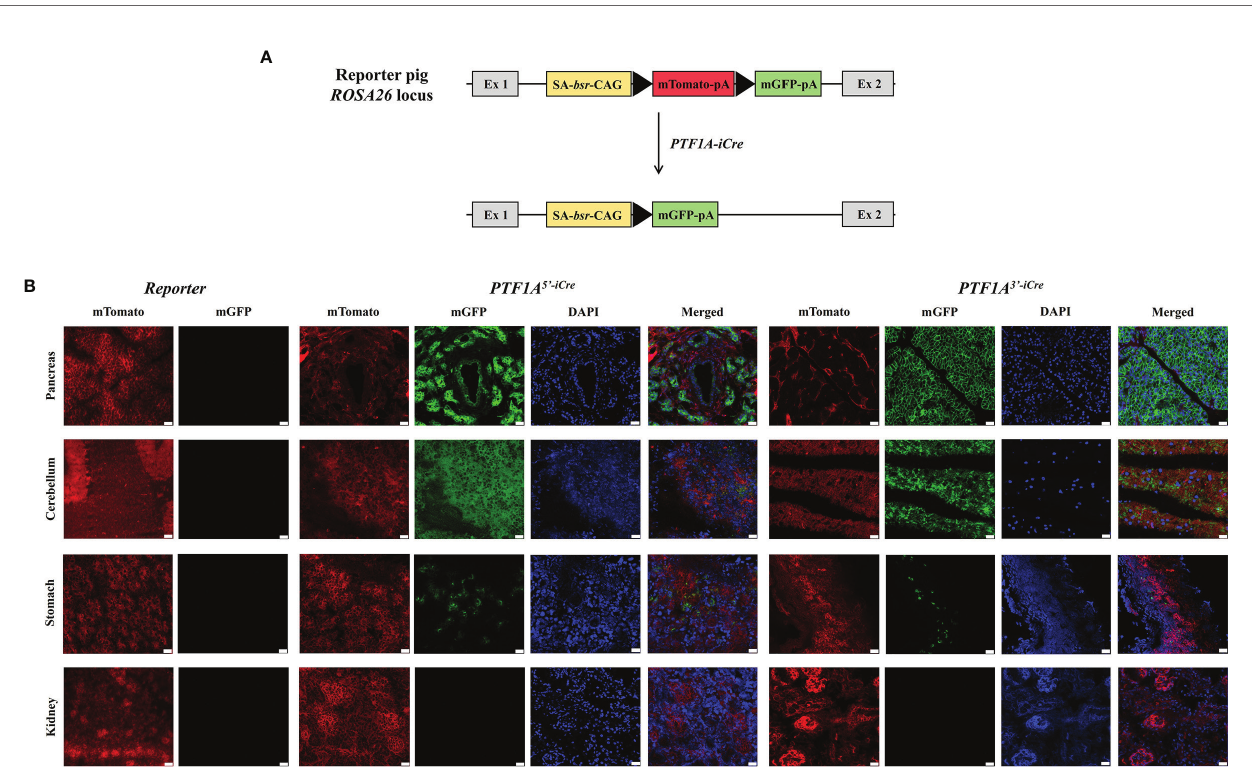
FIGURE 3 | Functional analysis of PTF1A-iCre using dual fl uorescent reporter pigs. (A) Schematic representation of the R26 mT/mG before and after Cre- recombination. (B) mTomato/mGFP fl uorescence in tissues collected from R26 mT/mG / PTF1A 5 ’ iCre or PTF1A 3 ’ iCre piglets. Scale bar represents 20 µm. Ex, exon; SA, splice acceptor; bsr, blasticidin resistance gene; CAG, CAG promoter; triangle, loxP site; pA, polyA